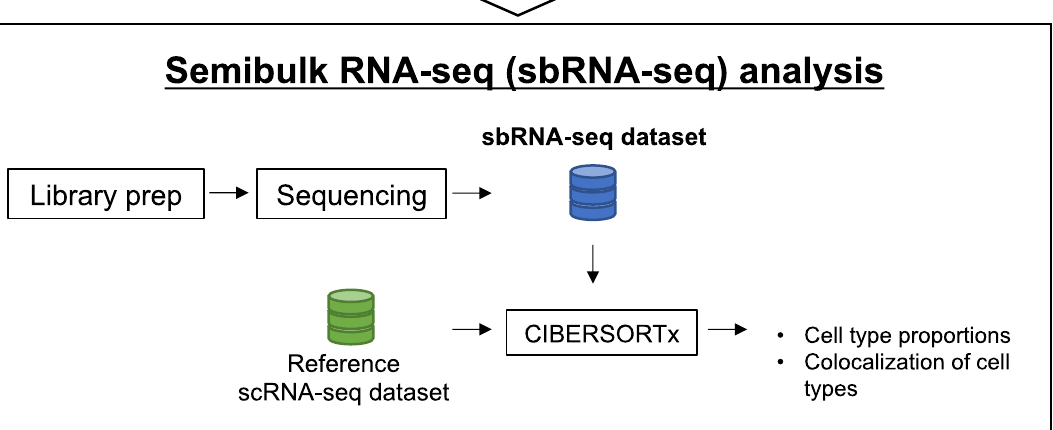
Figure 1. A workflow of sbRNA-seq. Overall schematic representation. Cell aggregates from tissues are isolated and mixed with a barcoded bead and reaction solution within a droplet. In the droplet, reverse transcription is conducted to generate barcoded cDNA. Library preparation and sequencing are performed to generate sbRNA- seq data. After sequencing, deconvolution analysis is conducted using CIBERSORTx 25 to estimate the cell-type proportion of each semibulk using scRNA-seq data as a